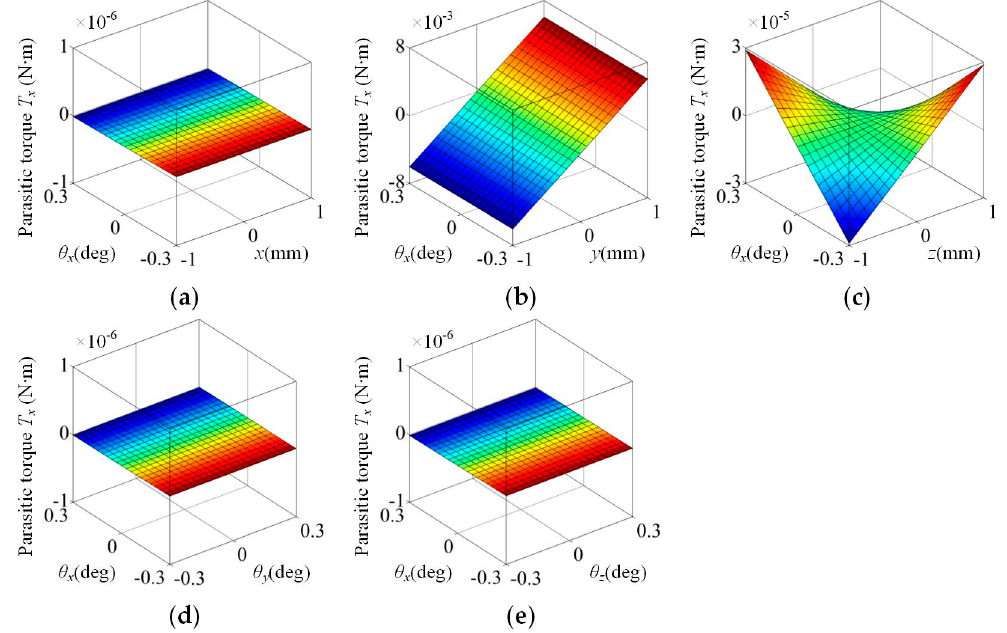
Figure 10. Parasitic torque T x characteristic of the HMF-VCA varied with the mover’s motion. ( a ) T x vs. θ x and x . ( b ) T x vs. θ x and y . ( c ) T x vs. θ x and z . ( d ) T x vs. θ x and θ y . ( e ) T x vs. θ x and θ z .